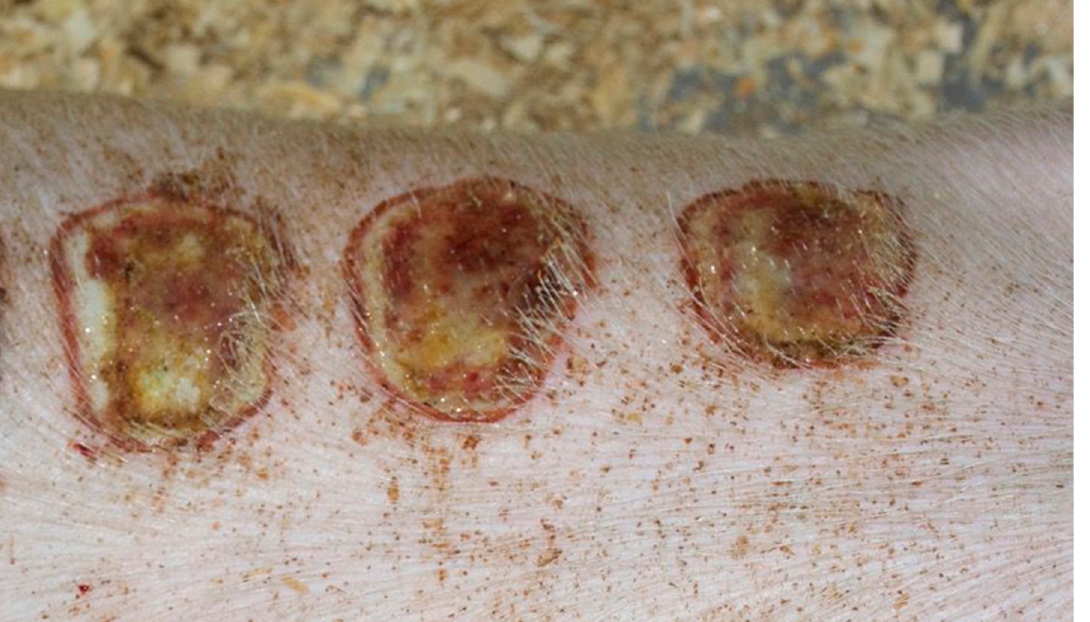
Figure 2. Group D2—burn wound treated with the 1% nanosilver ointment on day 5.